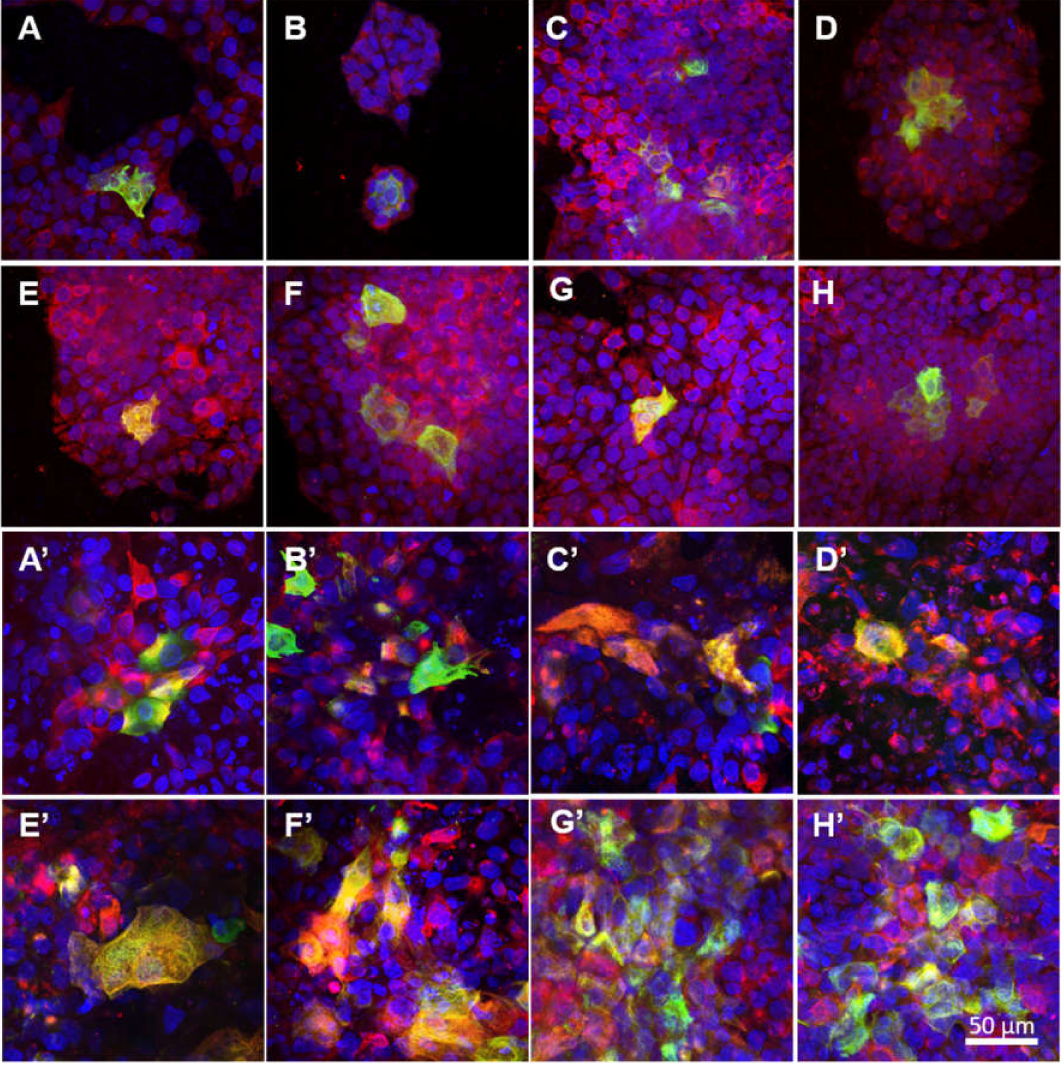
Figure 7. Immunofluorescence staining of the cytokeratin 10 (green) and cytokeratin 14 (red) in the HaCaT cells in the monoculture for the pure nanofibres ( A , A’ ) and nanofibrous membranes with differing PL concentrations, i.e., NF0 ( B , B’ ), NF1 ( C , C’ ), NF5 ( D , D’ ), NF10 ( E , E’ ), NF20 ( F , F’ ), NF50 ( G , G’ ), NF100 ( H , H’ ) ( A – H on day 7 and A’ – H’ on day 14). The cell nuclei were counterstained with Hoechst (blue). Leica SP8 confocal microscope, obj. ×